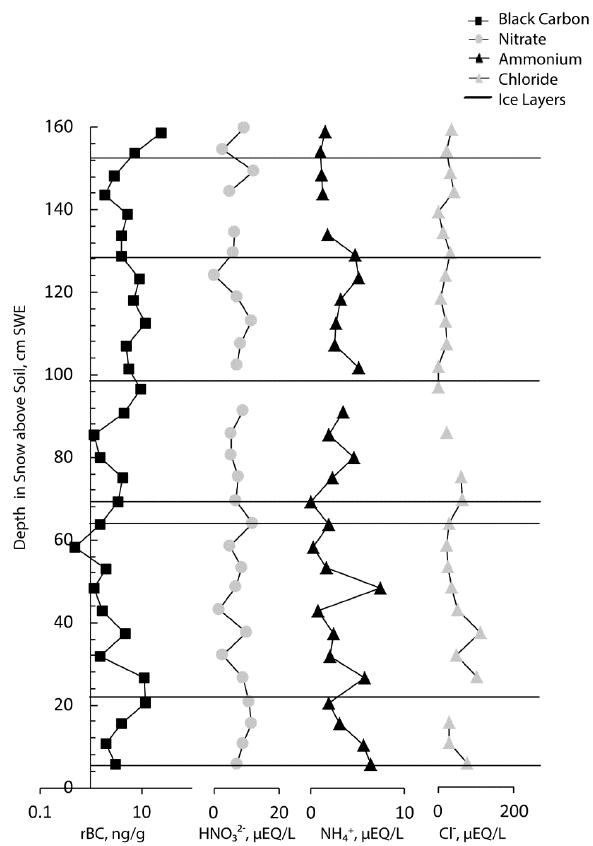
Fig. 4. 17 May snow pit rBC (ngg − 1 ) and soluble ion (µeqL − 1 ) concentrations versus snow depth (cm snow water equivalence above soil). Ice layer stratigraphy (indicated by horizontal dashed line) was observed in the field and suggests that ice layers may function as barriers for mobility of rBC and remaining soluble ions in snowpack.